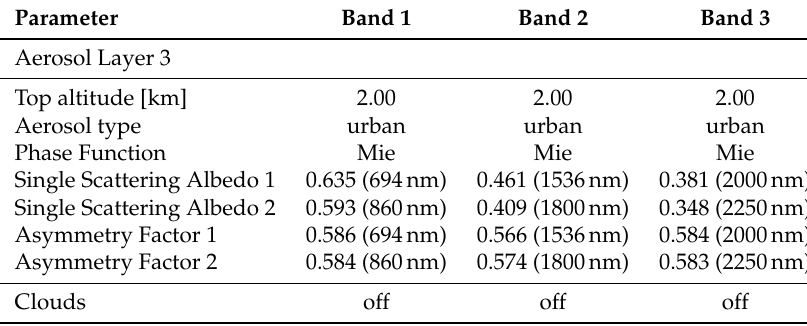
Table A11. Scattering parameters of scenario Rayleigh+Aerosol BG+Water cloud